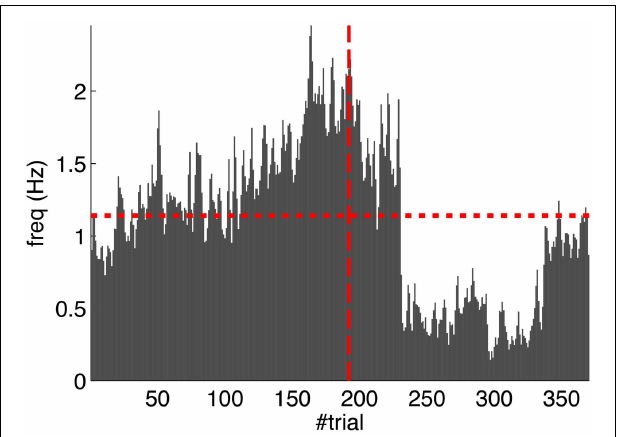
FIGURE 14 | Fluctuations in the spontaneous IO rate. Mean IO rate in each trial of the experiment.The horizontal dotted line marks the 1.14Hz level of activity.The vertical dashed line marks the transition from acquisition to extinction trials.